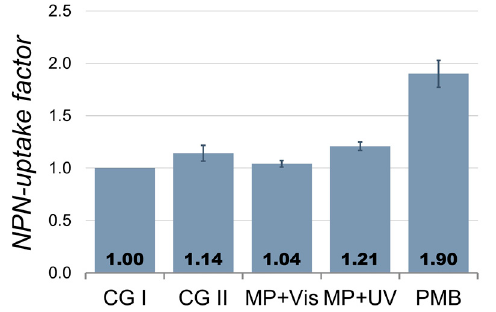
Figure 10. Effects of light and ZnO+Ni MP powder on S. Typhimurium outer membrane permeability. Two control groups represent data for S. Typhimurium bacteria which were maintained in the dark without (CG I) and with (CG II) ZnO+Ni MP powder, respectively. MP+Vis and MP+UV samples correspondingly show measures obtained with ZnO+Ni MP powder and Vis or UV light. PMB samples (bacteria treated by polymyxin B) were used as the additional control for fully permeabilized bacteria membranes. Table 2. The susceptibility of bacteria cells to antibiotics before and after treatment with ZnO+Ni. Tetracycline, µ